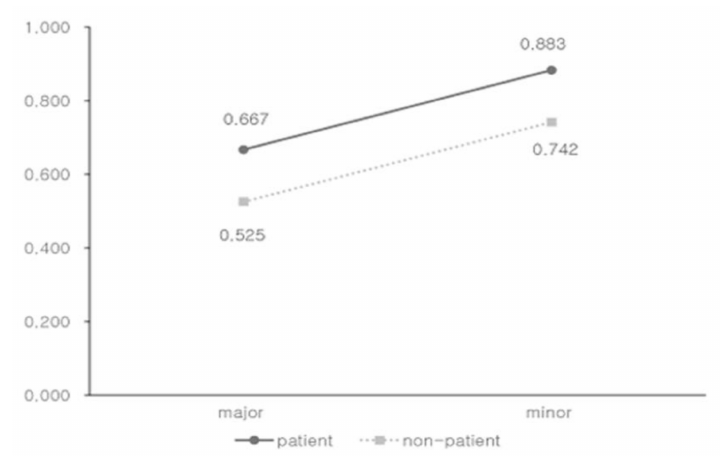
Figure 2. Estimated utility values for breast cancer stages stratified by respondent type, using the time-tradeo ff with the scales anchored by death to perfect health.